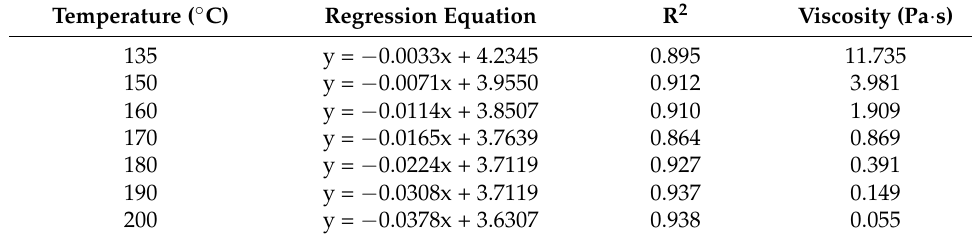
Table 6. Viscosity fitting results of